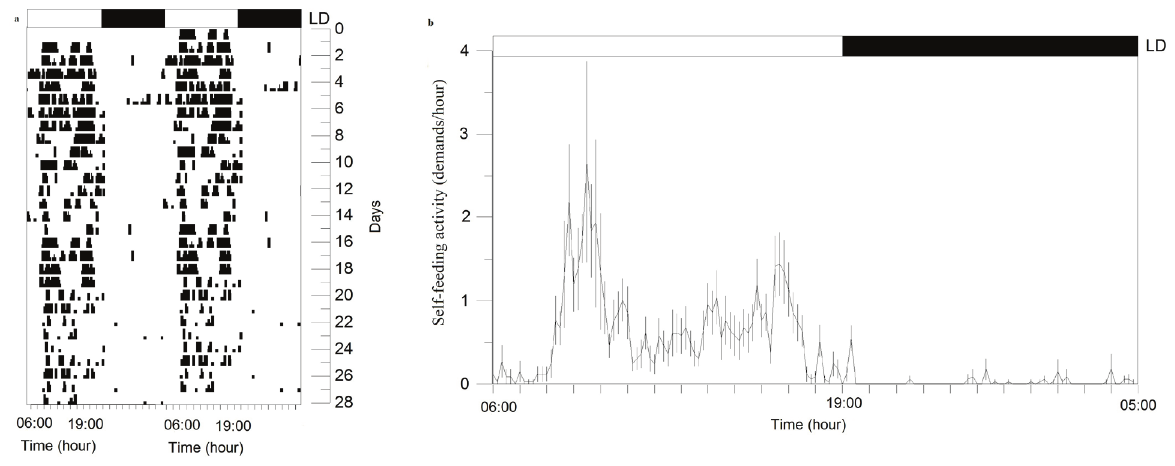
Figure 1 - Actogram ( a ) and average daily waveforms ( b ) for pirarucu’s ( Arapaima gigas ) feeding activity rhythms measured by a self-feeding system. The white and black bars at the top of the graph indicate the duration of the light (13 h) and night (11 h) phases, respectively.